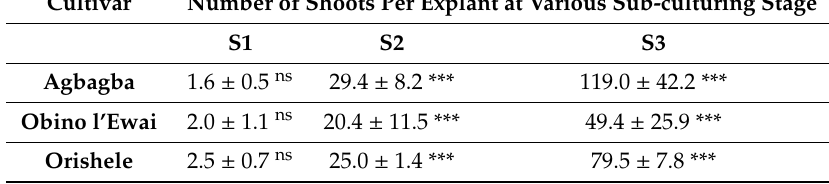
Table 1. The proliferation potential of various cultivars of plantain at di ff erent sub-culturing on proliferation medium.